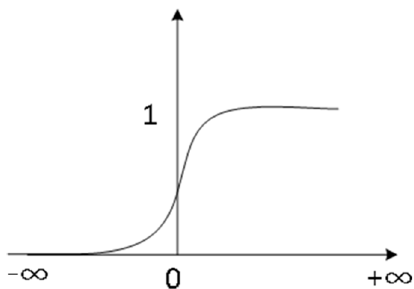
Figure 5. Sigmoid function.